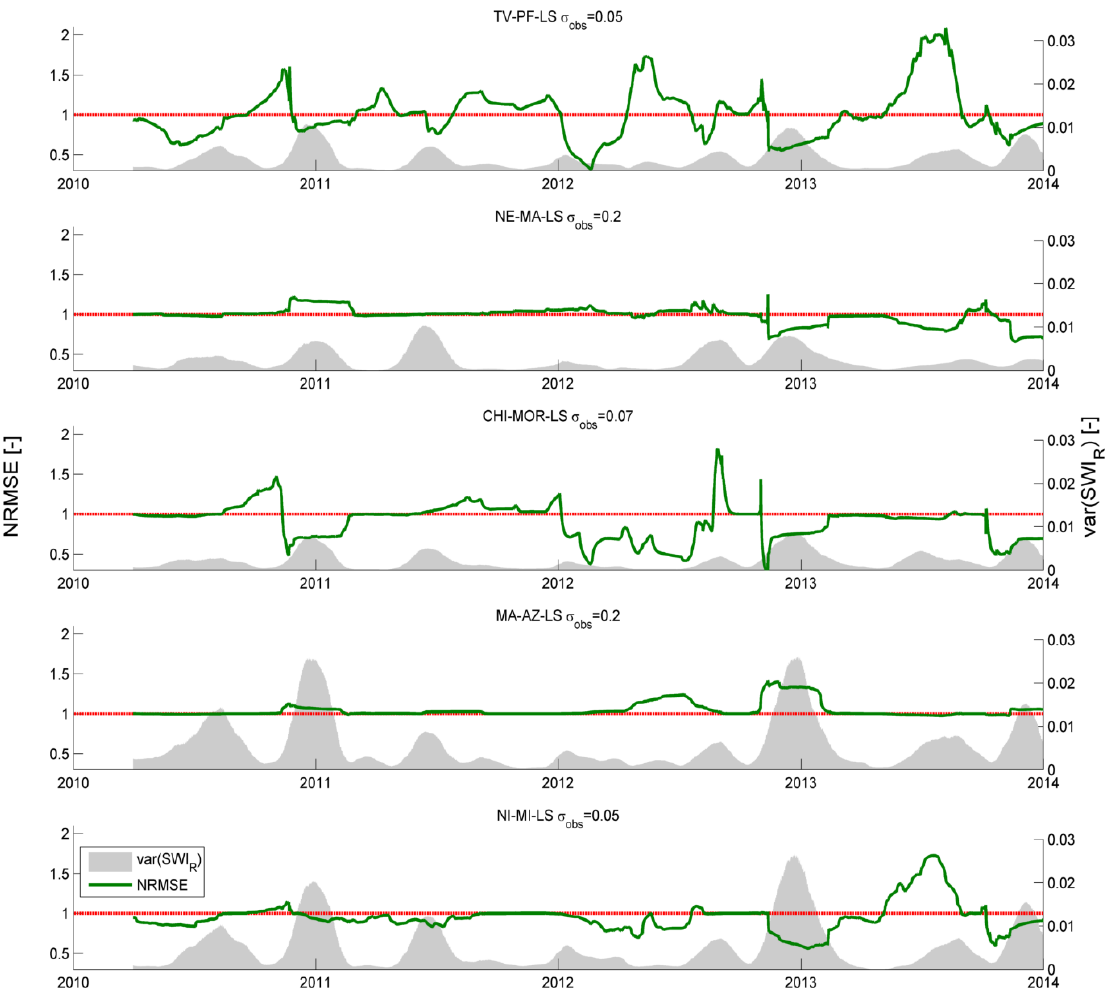
 for the five selected R SWI  generally correspond with R SWI